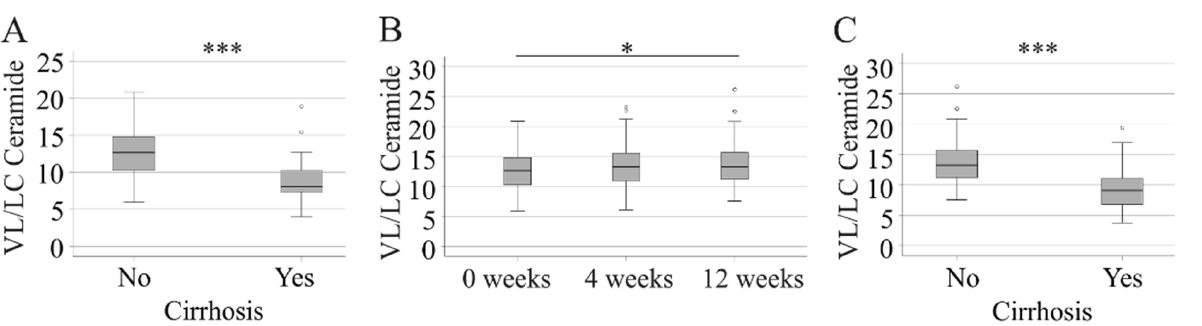
Figure 5. Very-long-chain to long-chain ceramide ratio (VL/LC). ( A ) VL/LC ceramide in 138 patients without and 40 patients with liver cirrhosis before the start of therapy; ( B ) VL/LC ceramide in patients without liver cirrhosis during the study. Data at 0 and 4 weeks for 138 patients and data at 12 weeks for 136 patients are shown; ( C ) VL/LC ceramide in 136 patients without and 40 patients with liver cirrhosis at week 12. * p < 0.05, *** p < 0.001.